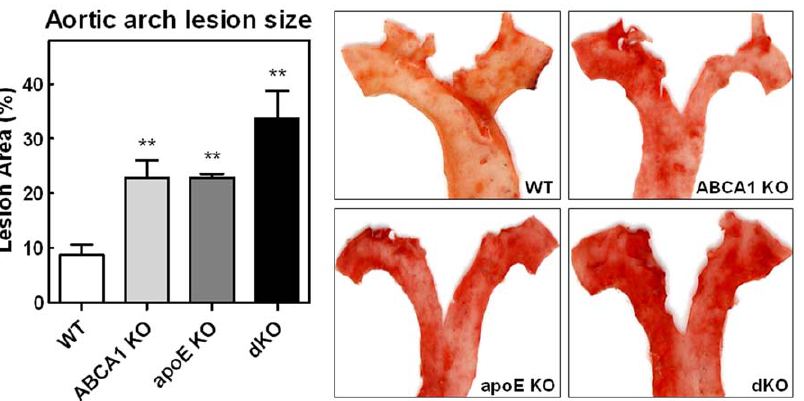
Figure 5. Analysis of atherosclerosis in the aortic arch of bone marrow transplanted LDLr KO mice after 9 weeks of HF/HC diet feeding. Relative plaque area in the aortic arch was quantified en face calculating the ratio of atherosclerotic lesions to the surface of the entire aortic arch (left panel). Representative pictures (right panels). **P , 0.01 as compared to WT transplanted controls.